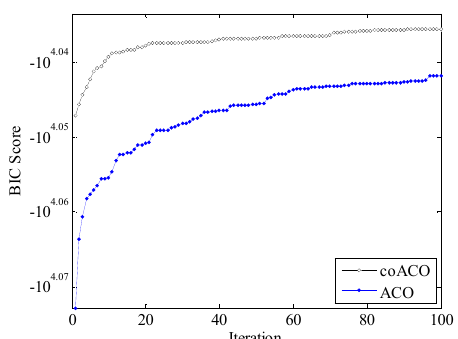
Figure 8. Evolution curves of the average BIC score achieved by ACO and coACO on the ASIA dataset with n = 10,000.